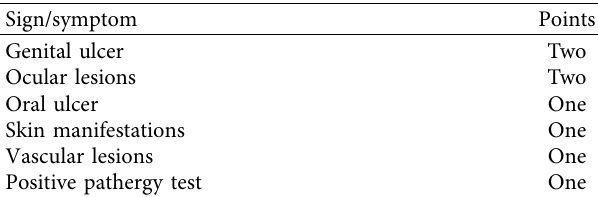
Table 1: International Criteria for Bechet’s Disease (ICBD) point score system: scoring 3 or more indicates Bechet’s disease